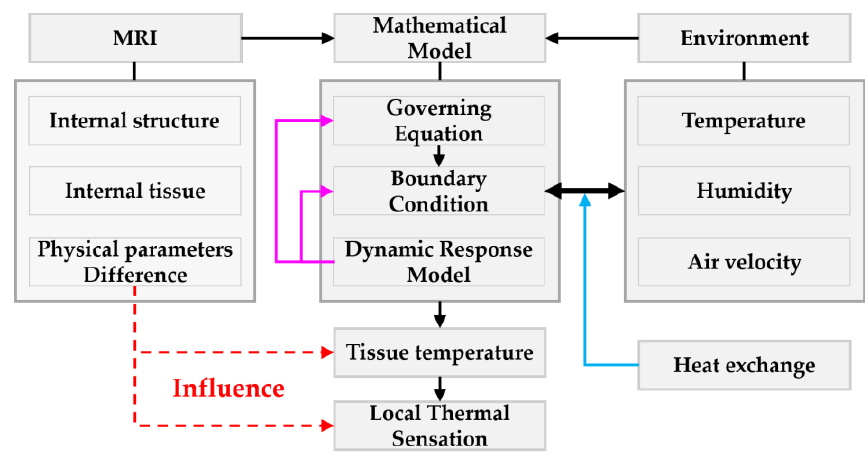
Figure 3. The methodology framework of the study